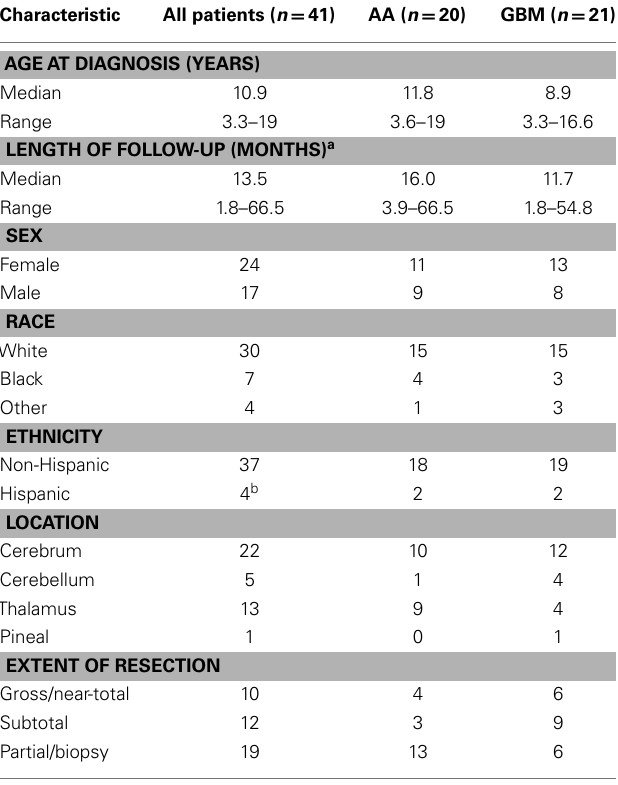
Table 2 | Patients’ characteristics.